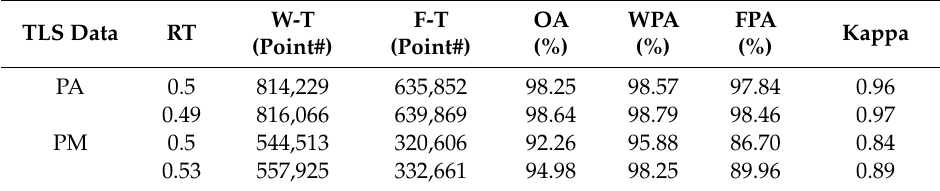
Table 3. The classification accuracy of the FWCNN model after setting the reclassification threshold (RT) as 0.5 or using the RT values determined by the Natural Breaking (NB) method. In this table, the F-T and W-T mean the number of foliage and woody points that were correctly classified within the test sets. The OA means the overall classification accuracy. The FPA and WPA mean the producer’s accuracy of foliage and woody points in the classification results,